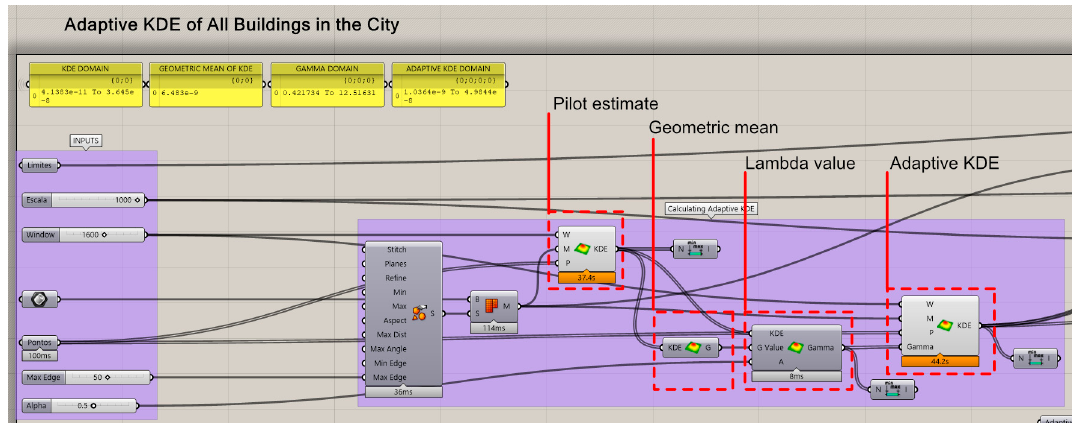
Figure 2. Visual programming script developed in Grasshopper for generating an adaptive Kernel Density Estimation (KDE) from input points and a surface. Source: